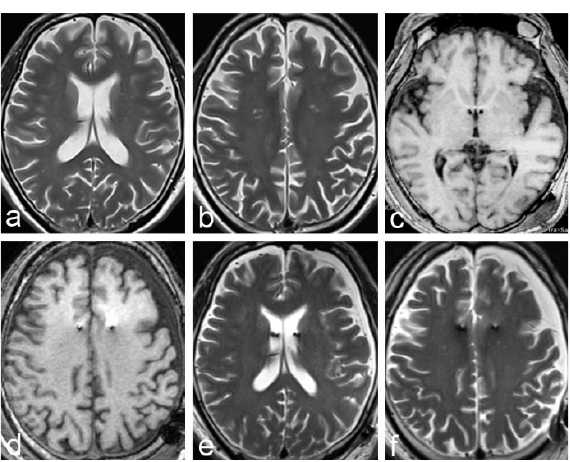
Figure 3. MRI images in patient 2 before the formation of chronic subdural hematoma. ( a , b ) Preoperative MRI shows cerebral atrophy, and that the left subarachnoid space is wider than the right; ( c – f ) Five days postoperatively, MRI (3DT1 and T2 image)shows bilateral subdural effusion that is more obvious on the left side. The lateral ventricle is slightly reduced, and the fornix-hypothalamus electrode passes through the bilateral lateral ventricles.